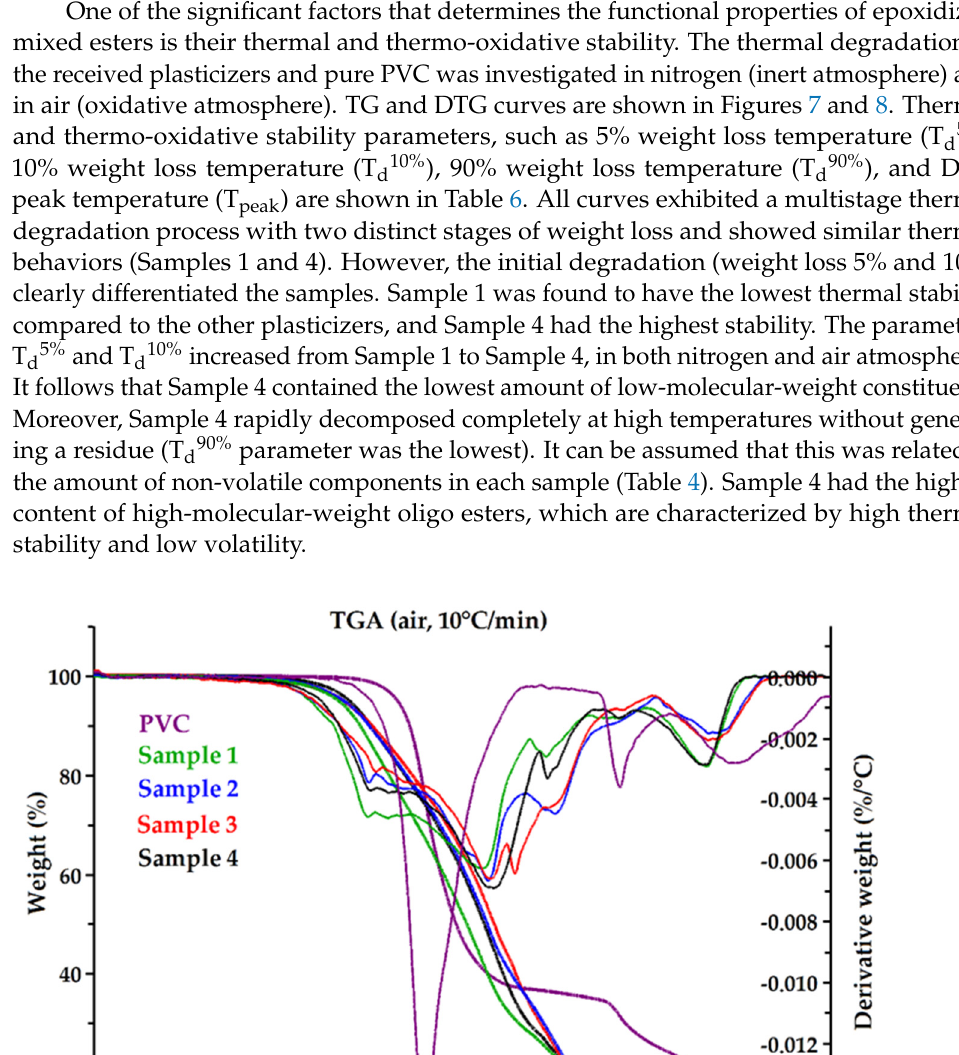
Figure 8. The TG and DTG curves of epoxidized mixed esters (Samples 1–4) and pure PVC in nitro- gen. Table 6. Thermal and thermo-oxidative stability parameters of epoxidized mixed esters (Samples 1–4) and pure PVC. Sample